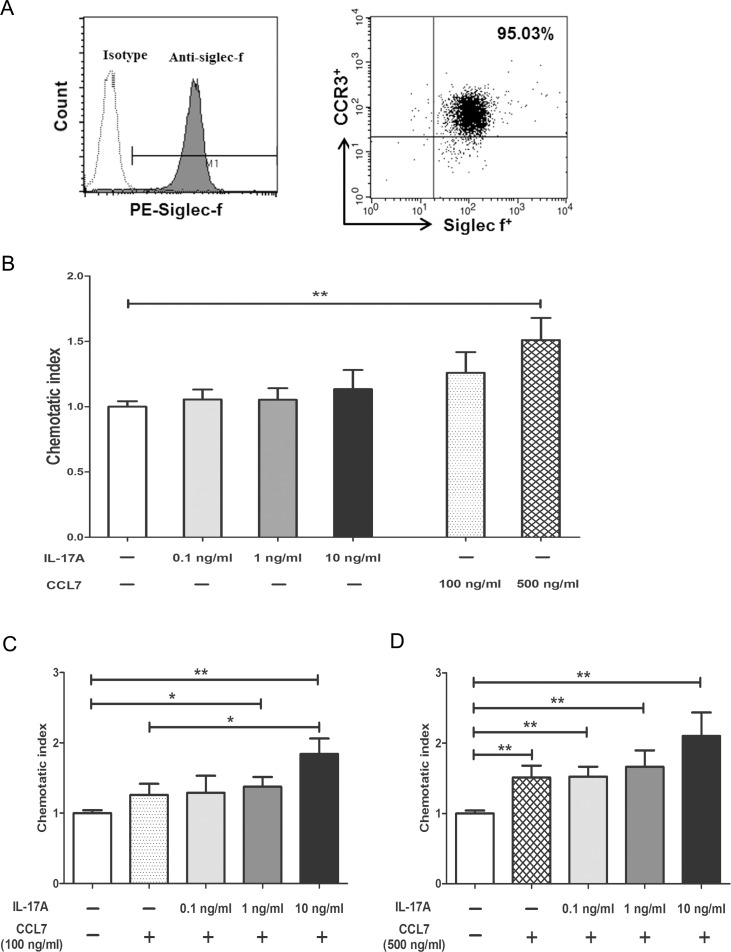
Comparison of chemotactic responses in bone marrow-derived eosinophils (bmEos).(A) BmEos were cultured until a high-purity (>95%) was reached. (B-D) BmEos were suspended and placed on the upper chambers, in the presence or absence of CCL7 and/or IL-17A, kept in the bottom chamber. BmEos without IL-17A and CCL7 proteins were used as the control. The bmEos exhibit chemotaxis to (B) 100 or 500 ng/mL CCL7 and various concentrations (0.1, 1 and 10 ng/mL) of IL-17A protein, respectively. (C) 100 ng/ml of CCL7 coupled with IL-17A (0.1, 1 and 10 ng/mL), (D) 500 ng/ml of CCL7 coupled with IL-17A (0.1, 1 and 10 ng/mL). Results are means ± SEM (n = 4). (** P < 0.01, * P < 0.05).